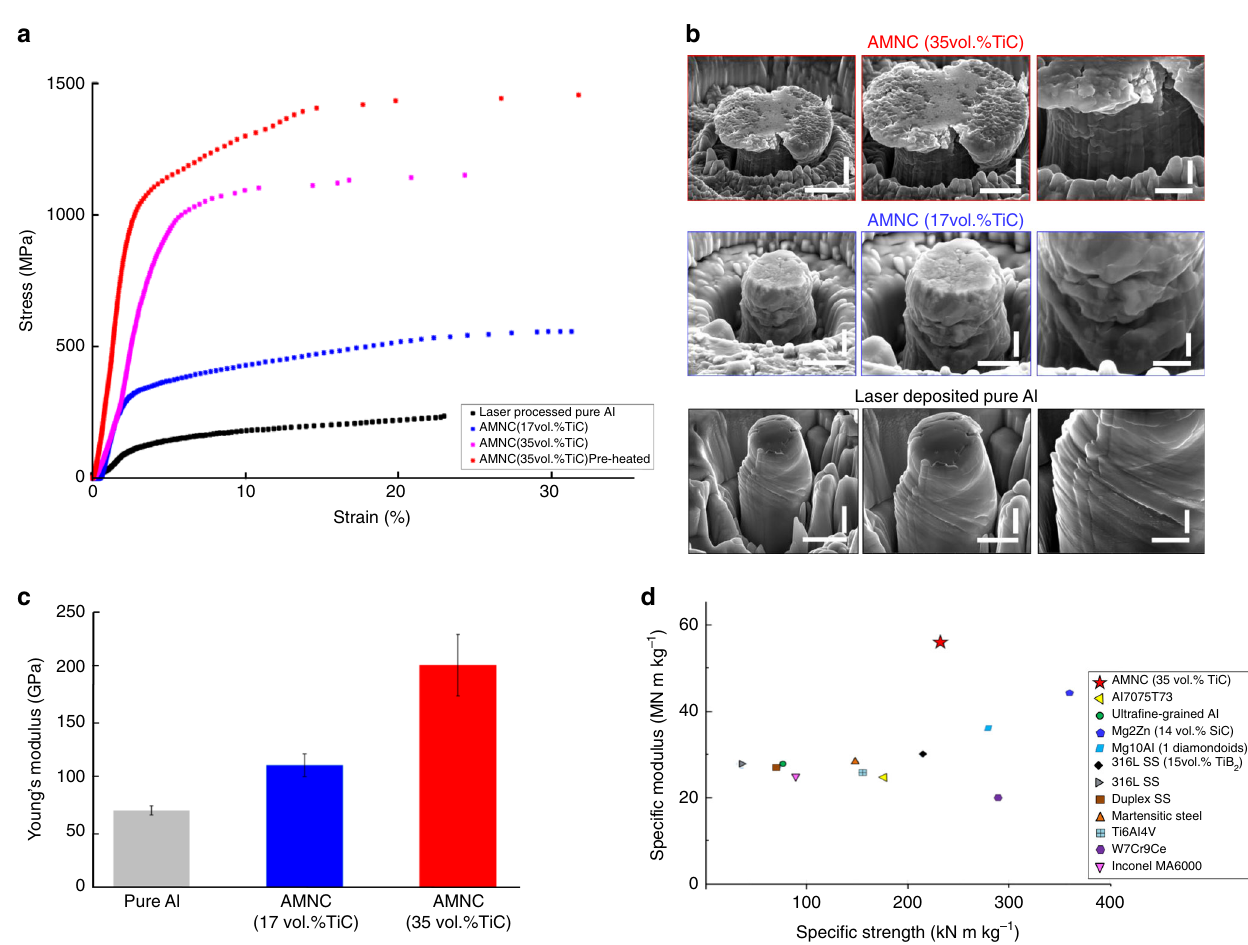
Fig. 3 Room-temperature mechanical behavior of laser-deposited aluminum with and without nanoparticles. a Typical engineering stress-strain curves of laser-deposited Al specimens with and without nanoparticles. b SEM images of micropillars after microcompression tests. c Young ’ s modulus of laser- deposited Al and AMNC specimens. Error bars represent SD for at least twenty data sets. d Speci fi c Young ’ s modulus and speci fi c yield strength of AMNC and other materials (all data from microcompression tests without size effect). Scale bar, 3 µ m (left), 2 µ m(middle) and 1 µ m(right) in